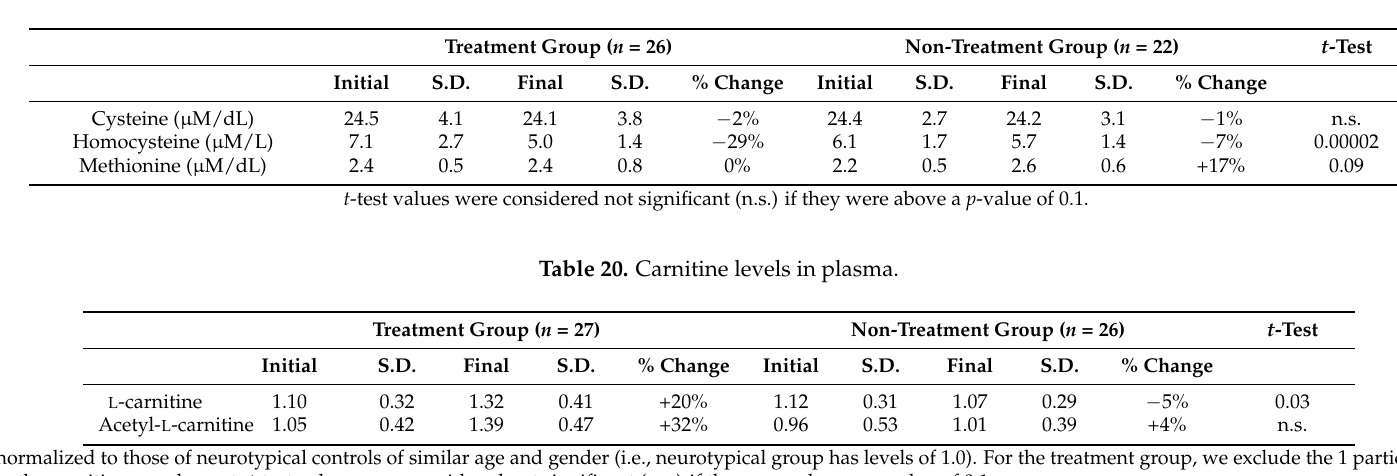
Table 19. Homocysteine Pathway.